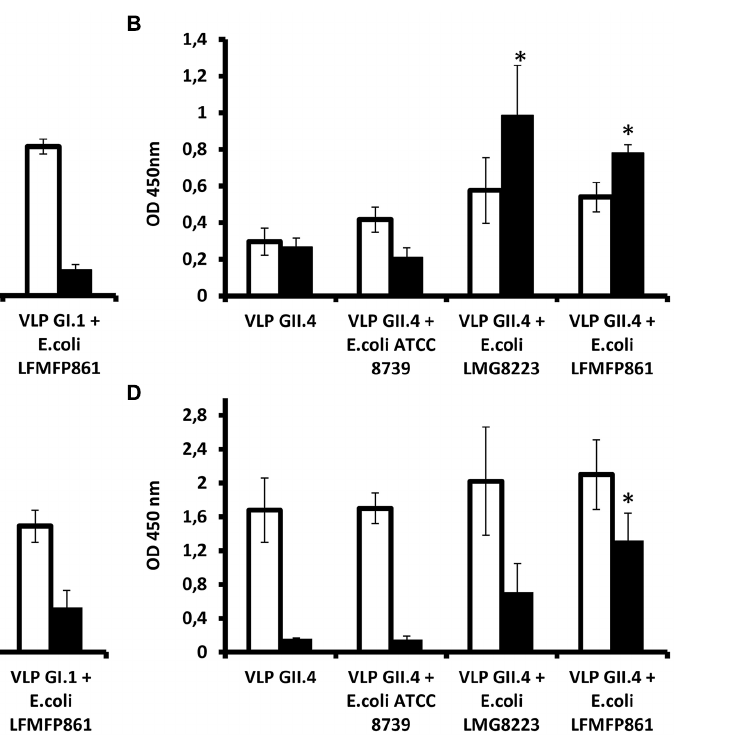
ELISA results of NoV GI.1 and GII.4 in the absence of bacteria, in the presence of non-HBGA expressing E. coli ATCC8739 or HBGA expressing E. coli LMG8223 and LFMFP861 before (white bars) or after (black bars) heat treatment at 90 ◦ C for 2 min. ∗ Significant differences as explained in the Section “Results.” Each data point is an average of three independent tests, and each error bar represents the data range.